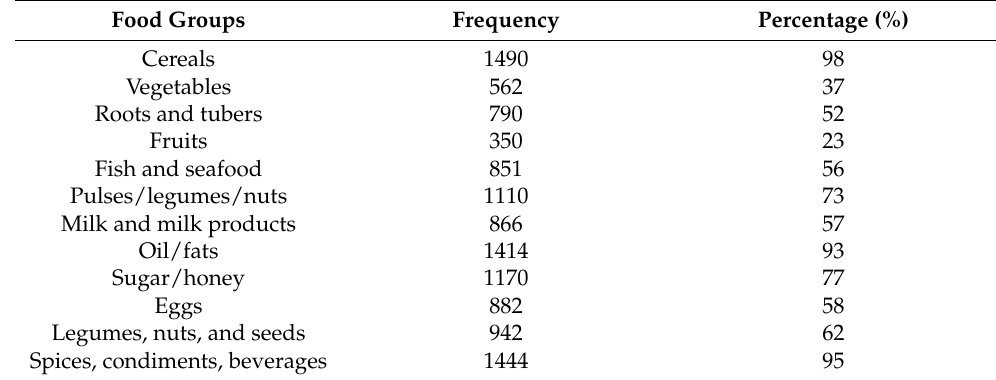
Table 1. Food groups consumed by households in Mpumalanga and Limpopo provinces in the past seven